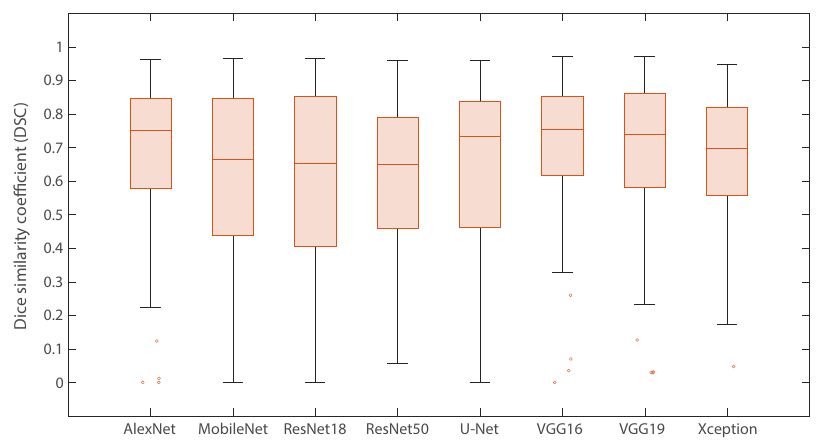
Figure 4. Boxplots demonstrating the median, minimum, maximum, first quartile, and third quartile values of the DSC scores for all individual models.